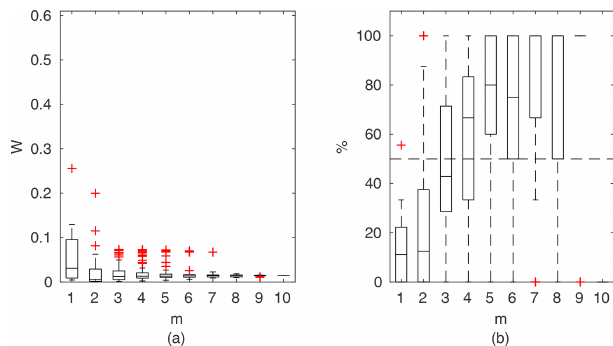
Figure 7. Pasche results for the flume data set, case 2: (a) averaged relative confidence widths W as a function of observation set size m used for model identification; (b) percentage of verification points enclosed by confidence intervals (100% denotes all points within intervals, box spans over the 25% and 75% quantiles, the median is given with horizontal line, whiskers indicate the result extent, and cross marks are for extreme values).